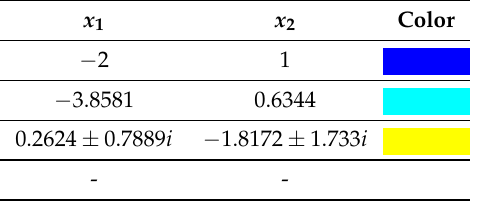
Table 1. Solutions of the 4th-order system for p 1 = − 4 and p 2 =